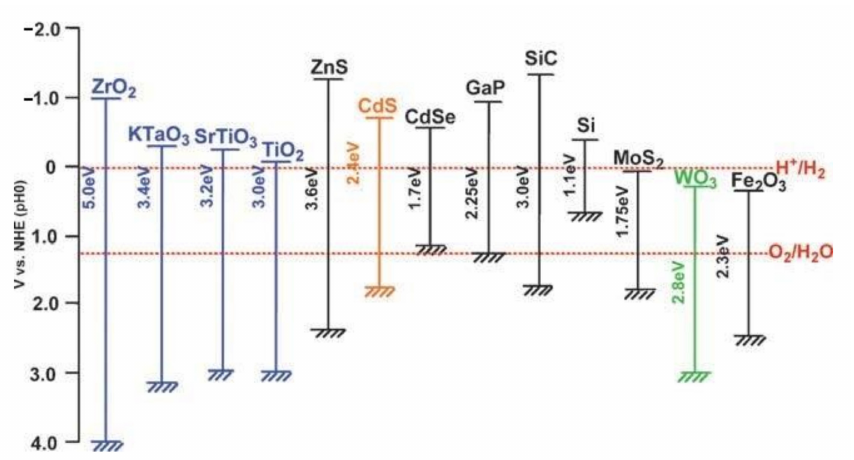
Figure 1. The band gaps of some semiconductors